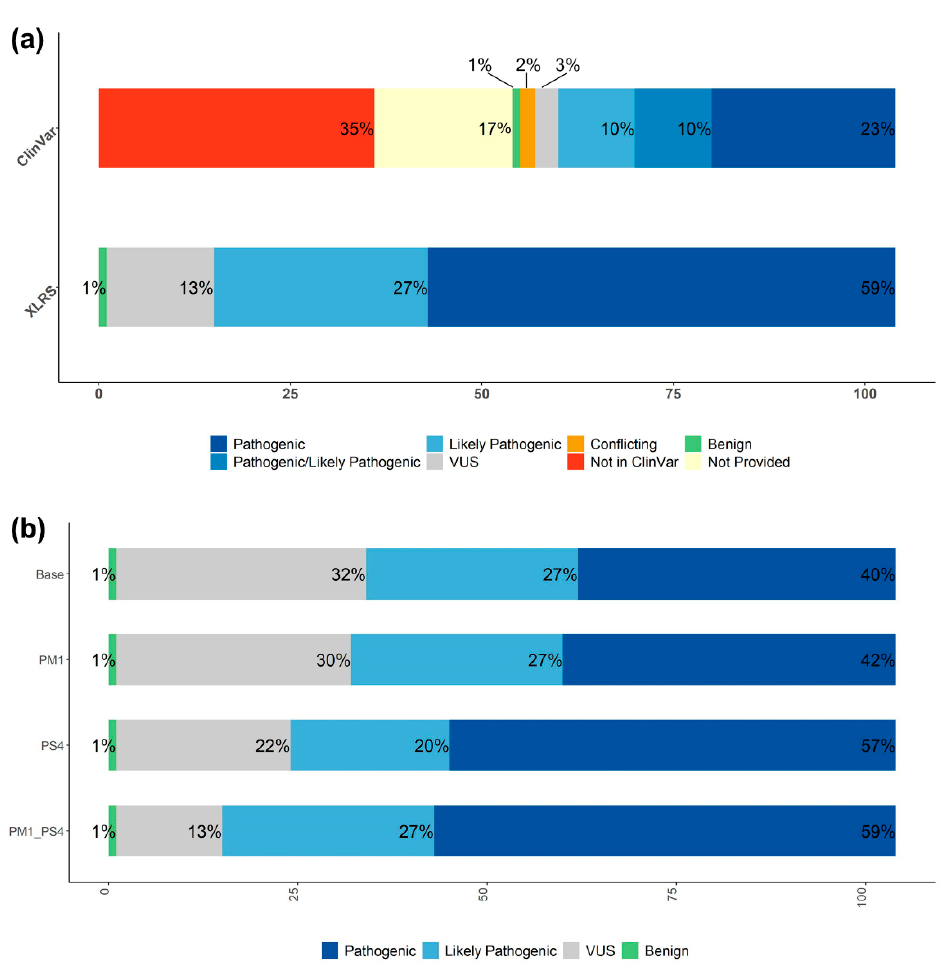
Figure 2. Variant analysis using the ACMG/AMP classification system, including 104 SNVs and small Indels. ( a ) Variant interpretation in the current study as compared to ClinVar interpretations. ( b ) Variant interpretation with and without application of PM1 and PS4.